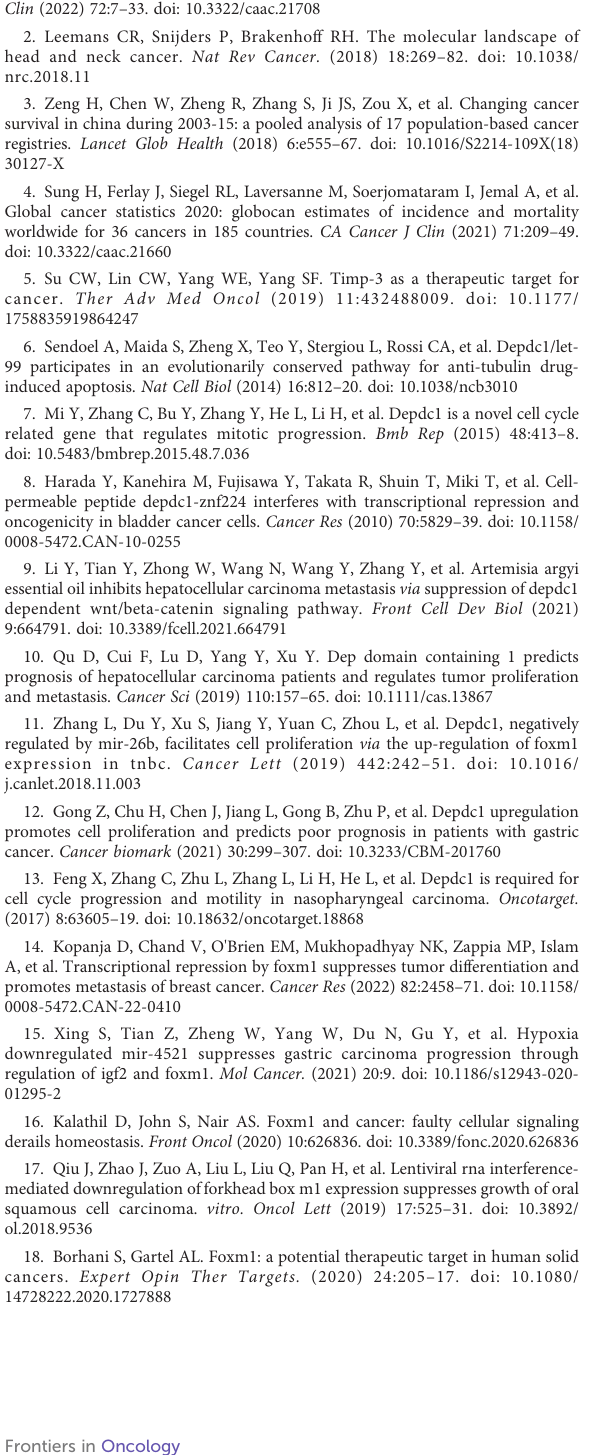
SUPPLEMENTARY FIGURE 2 SCC-25 cell DEPDC1 was knocked down and overexpressed in the CAL-27 cells. (A) Detection of DEPDC1 expression in SCC-25 cells after down- regulated by sh-DEPDC1. (B) Detection of DEPDC1 expression in CAL-27 cells after upregulated by OE-DEPDC1. **P < 0.01. The data are presented as the mean±SD, and are representative of at least 3 independent experiments.